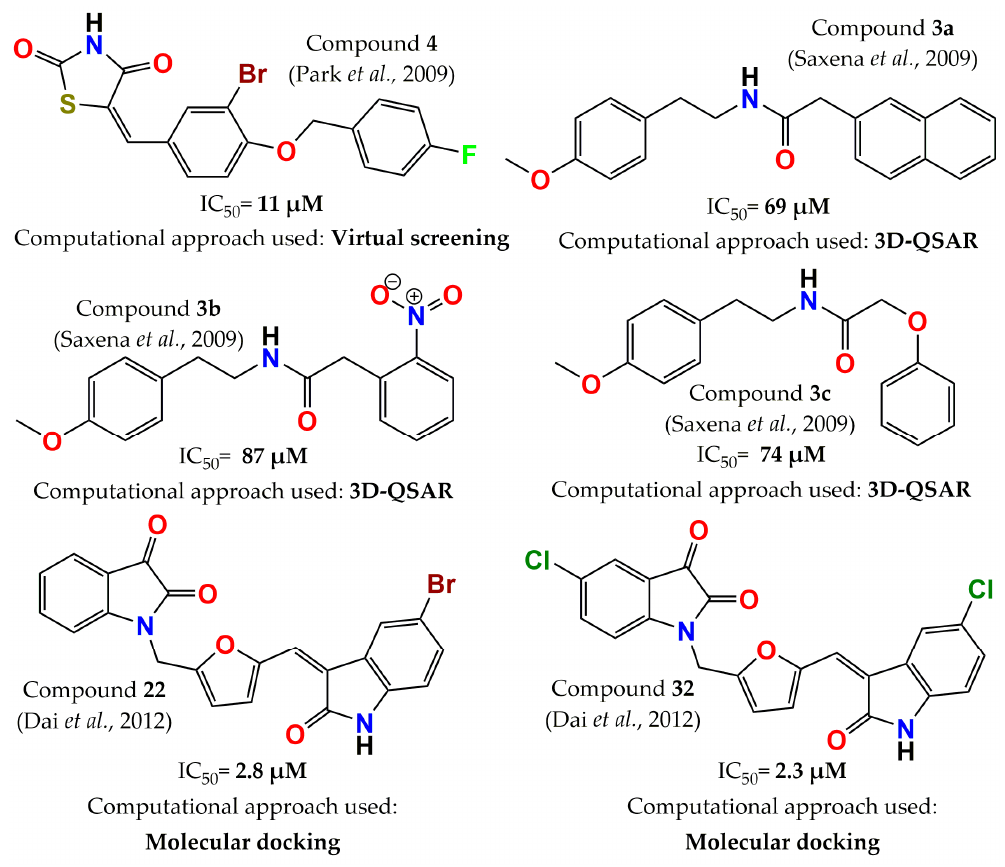
Figure 5. Structure of the most potent PTP1B inhibitors reported between 2009 and 2012 discovered through computational approaches. through computational